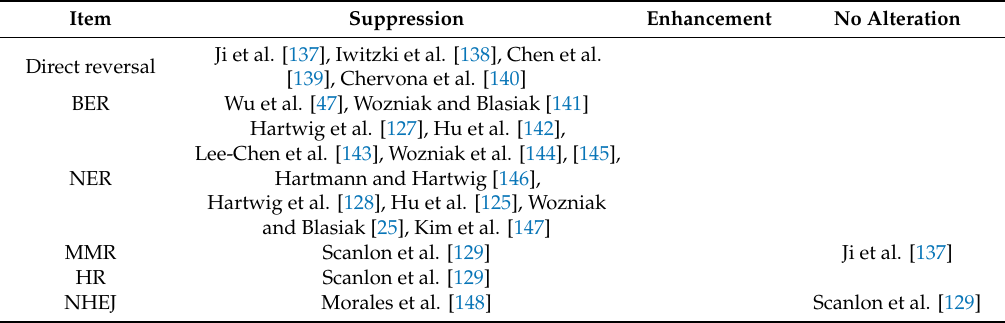
Figure 2. DNA damage repair systems. DNA damage repair systems include direct reversal, base-excision repair (BER), nucleotide repair (NER), mismatch repair (MMR), homologous-recombination repair (HR), and nonhomologous end joining (NHEJ) repair pathways. Table 1. Effect of Ni on DNA damage-repair systems.